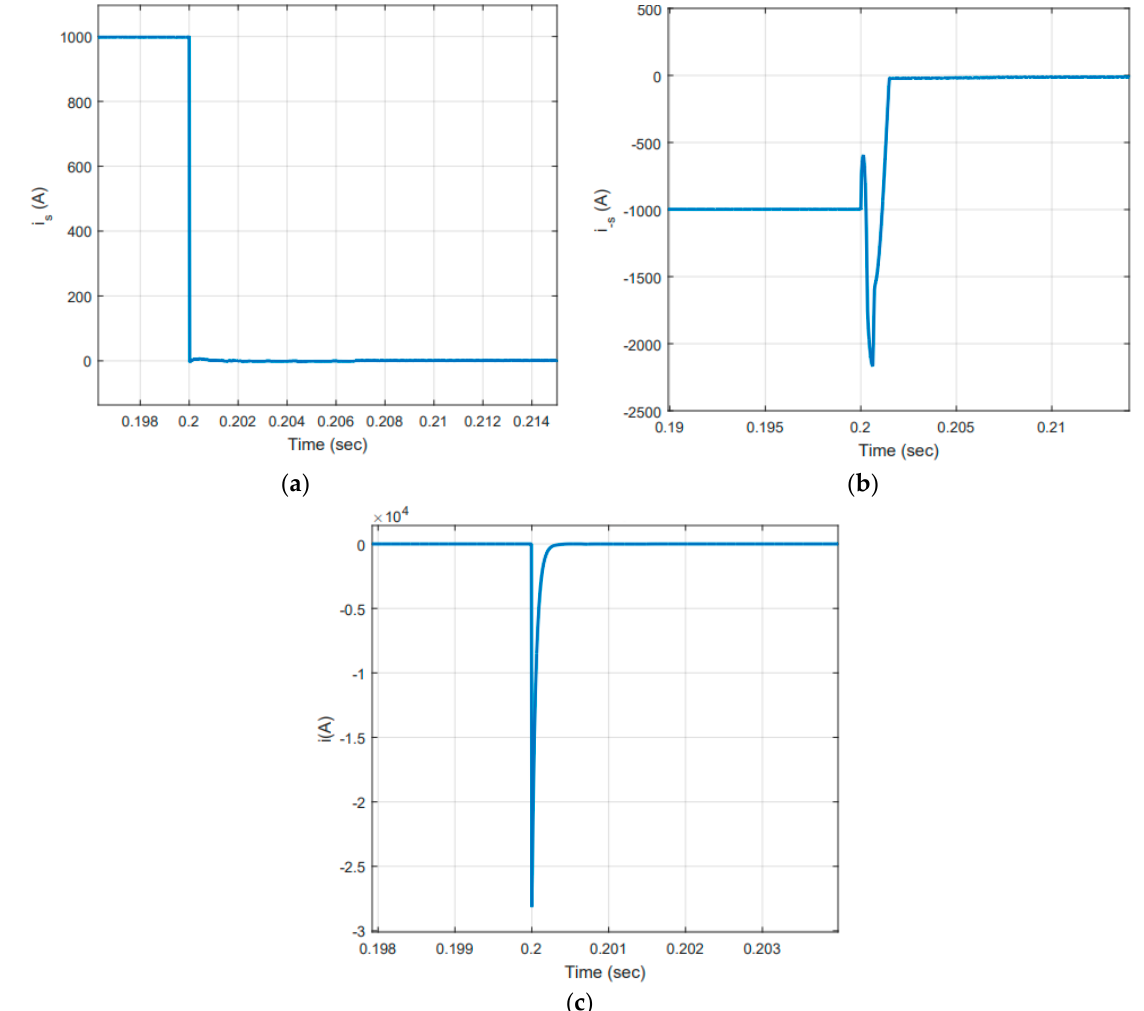
Figure 11. Pole-to-pole fault, ( a ) positive pole current, ( b ) negative pole current, and ( c ) terminal capacitor current.